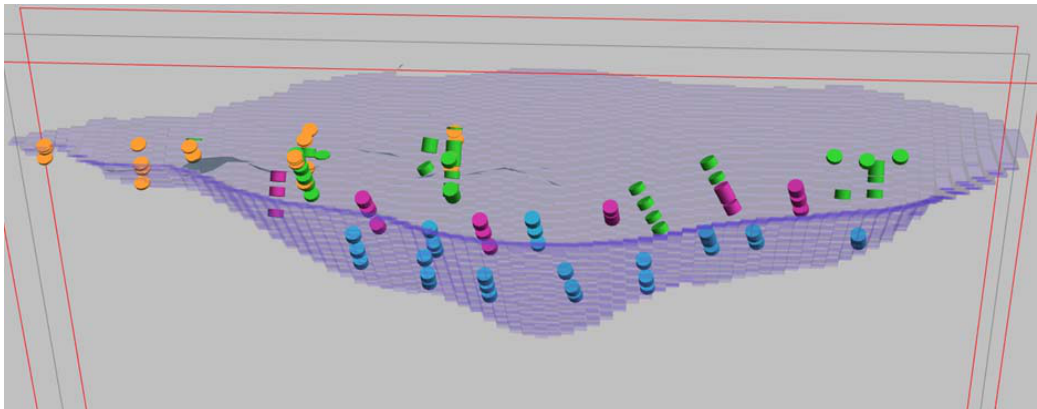
Figure 1. Spatial distribution of metallurgical composite samples. Orange: scoping stage phase 1; Green: scoping stage phase 2; Blue: pre-feasibility; and Pink: feasibility stage. A total of 87 composites were collected to support 295 recovery and 160 comminution tests. Some of the larger contiguous composites formed variability testwork samples. Total project reserve base 90 Mt. Pit strike length 1.8 km.